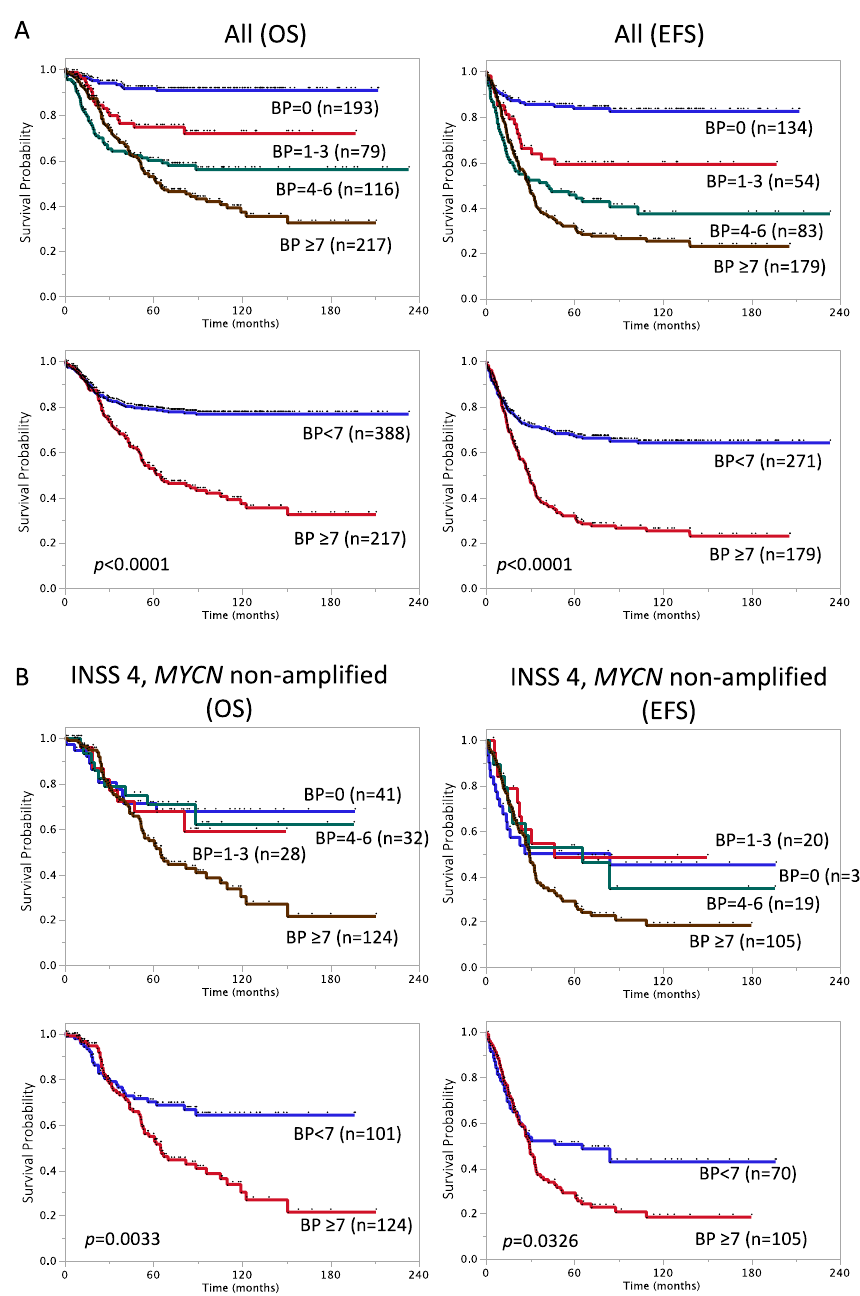
Figure 2. Kaplan–Meier survival curves of NB patients divided by the number of breakpoints. ( A ) OS and EFS of all patients. ( B ) OS and EFS of 225 stage 4, MYCN non-amplified cases. OS: overall survival; EFS: event-free survival; BP: the number of breakpoints.